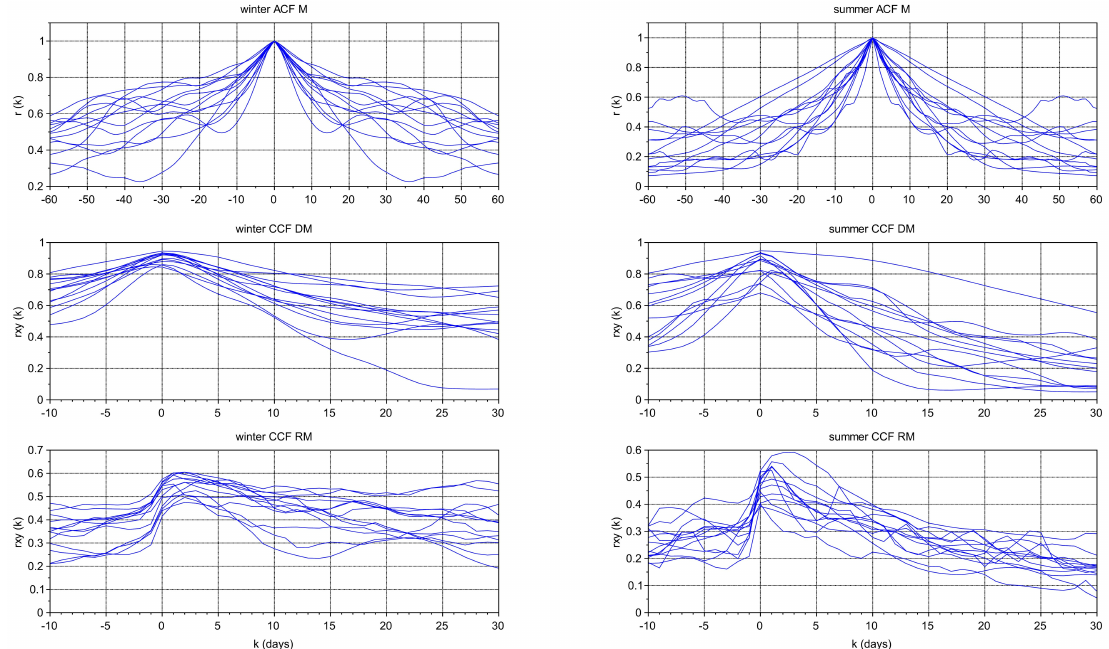
Figure 5. Autocorrelation functions for the Zagorska Mrežnica spring (ACF M), cross correlation functions between the swallow zone of the Drežniˇcko polje and the Zagorska Mrežnica spring (CCF DM), and cross correlation functions between rainfall data and the Zagorska Mrežnica spring (CCF RM) for the winter and summer parts of the hydrological year (over the period